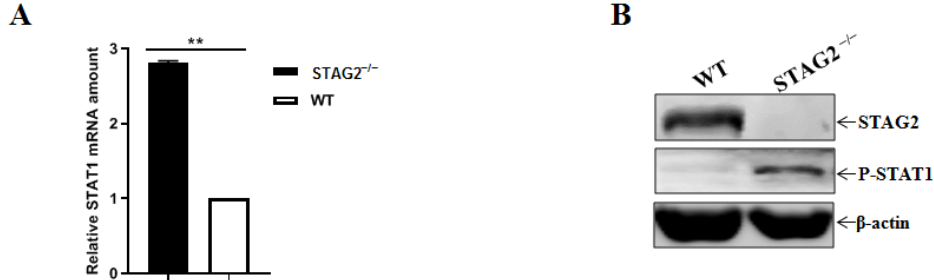
Figure 6. STAG2 deficiency activates the JAK-STAT signaling. ( A ) WT and STAG2 − / − cells were analyzed by quantitative RT-PCR. The results are representative of three independent experiments (the means ± SD). **, p < 0.01. The p value was calculated using Student’s t -tests; ( B ) WT and STAG2 − / − cells were analyzed by Western blot with the indicated antibodies.